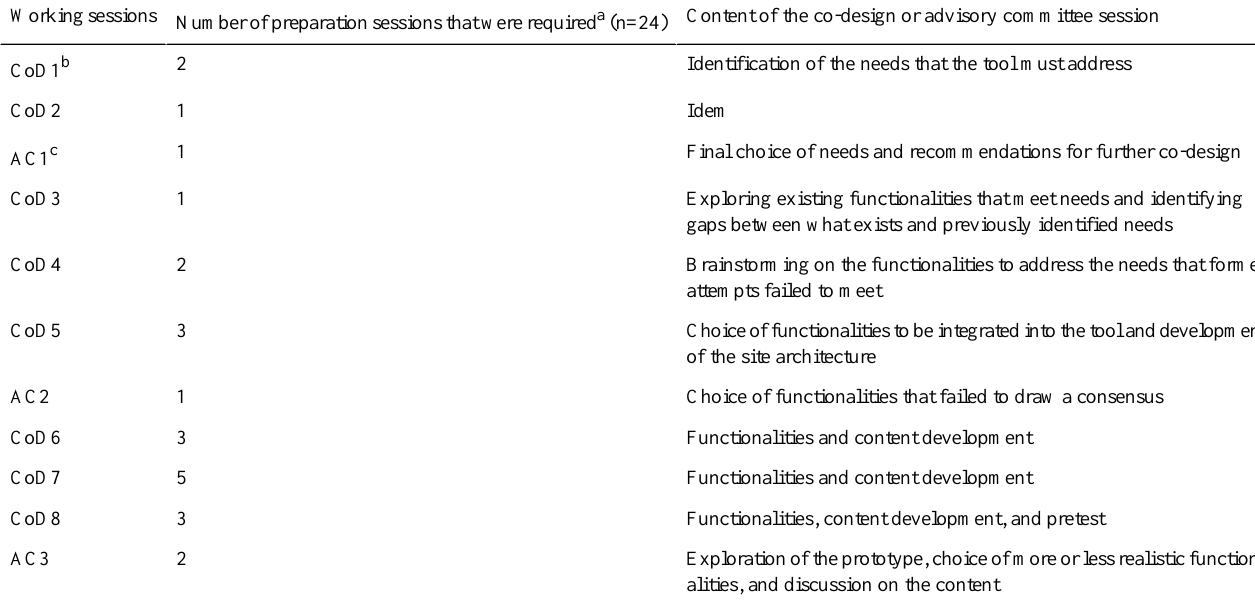
Table 1. Content covered in the co-design sessions and the number of preparation sessions required.